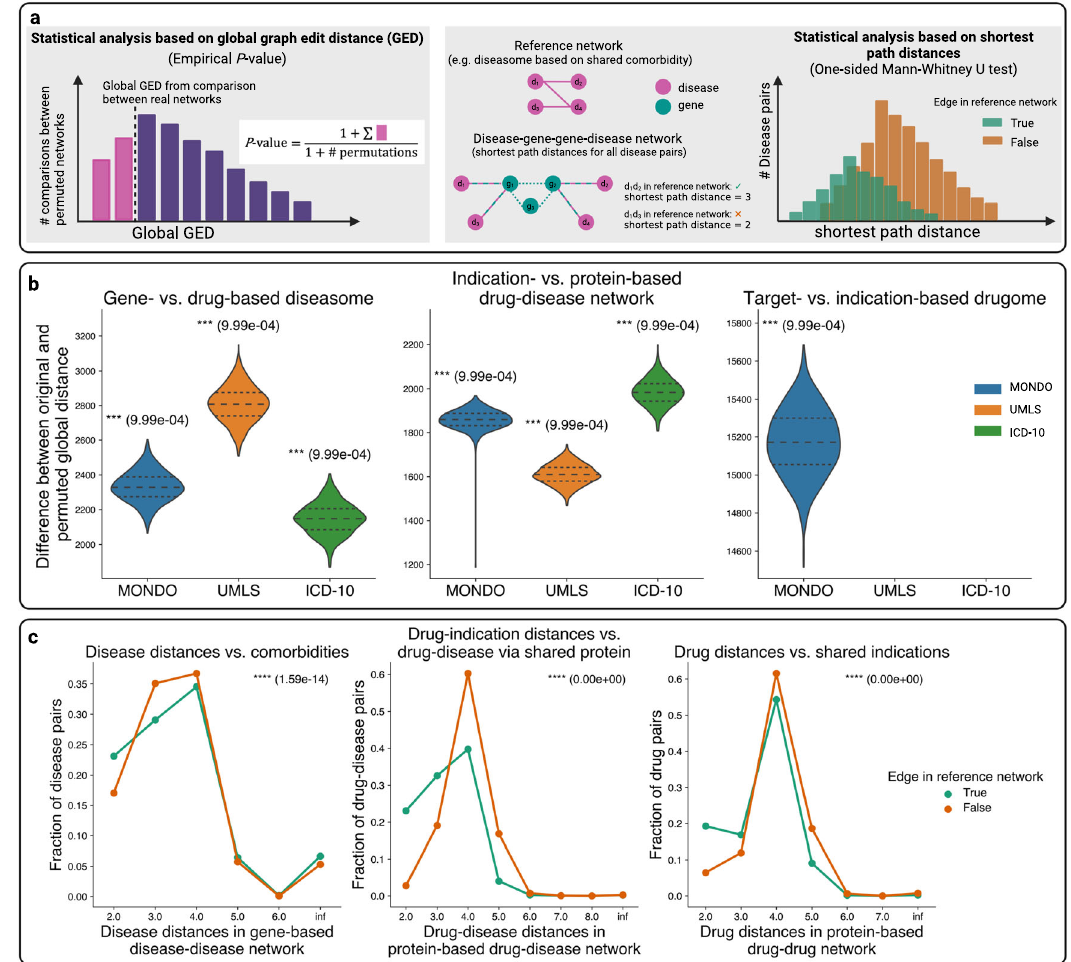
Fig. 4 | Global-scale analyses. a Illustration of global-scale analysis methods. Left panel: Statistical analyses based on global GED via empirical P -values. Right panel: StatisticalanalysesbasedonshortestpathdistancesviaMWUtest. b Differencesof global GEDs (based on uniform edge edit costs) between a selection of original networks and their counterpart permuted networks, and corresponding global empirical P -values (one-sided, unadjusted) in MONDO, UMLS, and ICD-10 voca- bularies. All obtained global empirical P -values are at the lower resolution limit of our permutation tests with 1000 randomized network pairs. c Selected results of